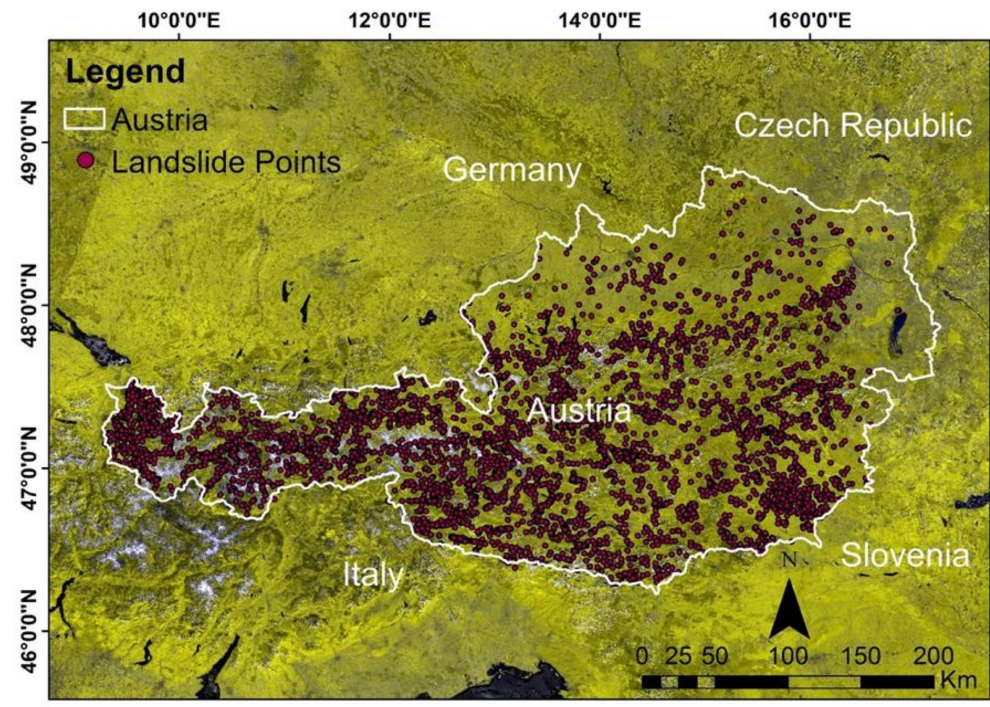
Figure 1. The study